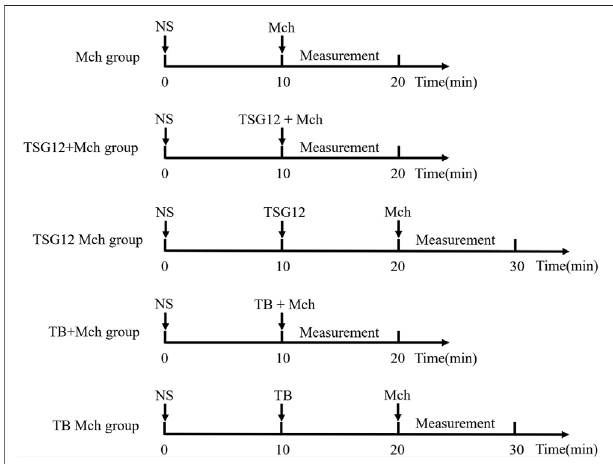
FIGURE 1 | Schematic of administration. The Mch group was administered with atomized NS at 0 min and Mch at 10 min. The TSG12 + Mch group was atomized with NS at 0 min and TSG12 together with Mch at 10 min. The TSG12 Mch group was atomized with NS at 0 min, TSG12 at 10 min, and Mch at 20 min. The TB + Mch group was atomized with NS at 0 min and TB together with Mch at 10 min. The TB Mch group was atomized at 0 min, TB at 10 min, and Mch at 20 min. Abbreviations: NS, normal saline; Mch, methacholine; TB, terbutaline.